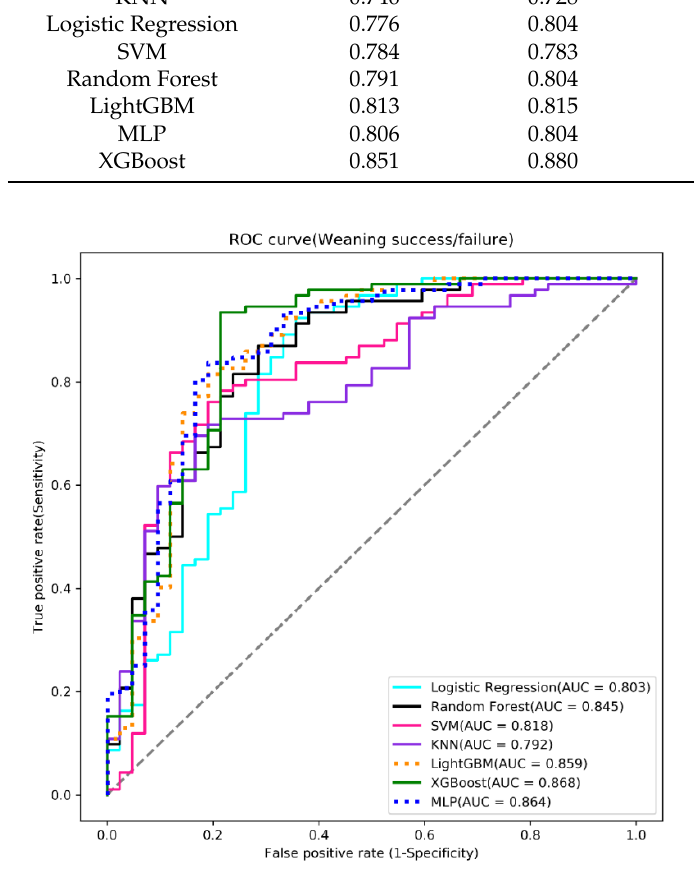
Figure 2. The receiver operating characteristic curve (ROC) of the testing results.